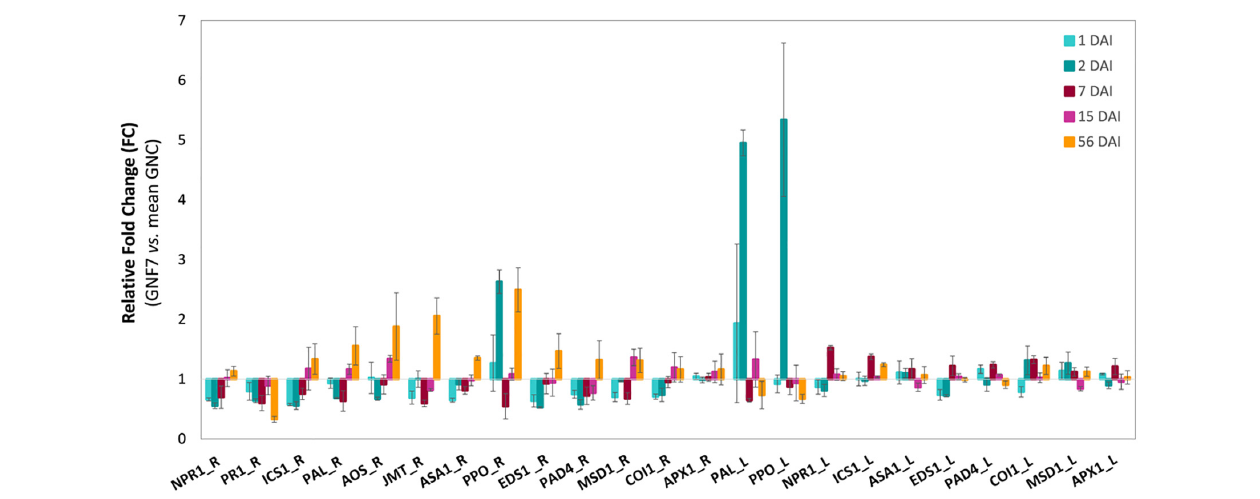
FIGURE 6 | Relative expression levels (fold changes) of defense-related genes in banana plants upon inoculation with Pseudomonas simiae PICF7. Non-expresser of PR 1 (NPR1), pathogenesis-related 1 (PR1), isochorismate synthase 1 (ICS1), phenylalanine ammonia-lyase (PAL), allene oxide synthase (AOS), jasmonic acid carboxyl methyltransferase (JMT), anthranilate synthase alpha subunit 1 (ASA1), polyphenol oxidase (PPO), enhanced disease susceptibility 1 (EDS1), phytoalexin deficient 4 (PAD), manganese superoxide dismutase 1 (MSD1), coronatine insensitive 1 (COI1), and ascorbate peroxidase (APX1). FC < 1, downregulation; FC > 1, upregulation; R, roots; L, leaves. Musa acuminata genes EF-1 and L2 were used as internal controls to normalize the expression. Error bars, standard error of the mean (SEM); DAI, days after inoculation; GNC, non-inoculated plants; GNF7, P. simiae PICF7-inoculated plants. GNC/GNF7 =